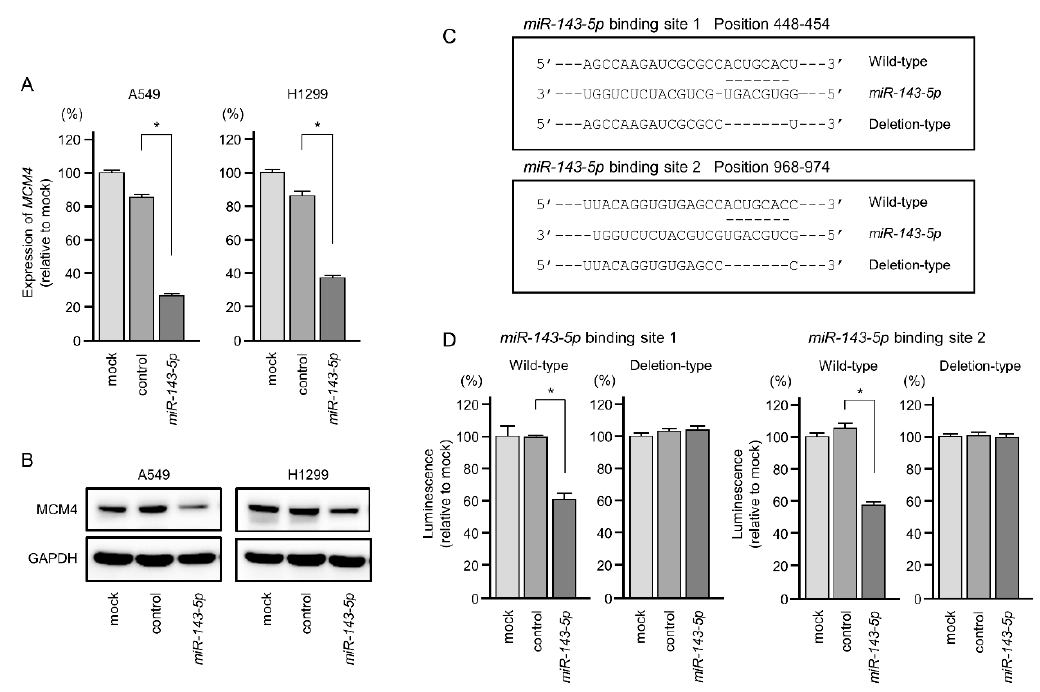
Figure 7. Expression of MCM4 /MCM4 was directly regulated by miR-143-5p in LUAD cells. ( A ) Expression of MCM4 mRNA was significantly reduced by miR-143-5p transfection into A549 and H1299 cells (72 h after transfection). Expression of GAPDH was used as an internal control. ( B ) Expression of MCM4 protein was reduced by miR-143-5p transfection into LUAD cells (72 h after transfection). Expression of GAPDH was used as an internal control. ( C ) TargetScanHuman database analyses predicted two putative miR-143-5p binding sites in the 3 ′ -UTR of MCM4 . ( D ) Dual luciferase reporter assays showed that luminescence activities were reduced by cotransfection with wild-type ( miR-143-5p binding site) vectors and miR-143-5p in LUAD cells. Normalized data were calculated as Renilla /firefly luciferase activity ratios (* p < 0.001).